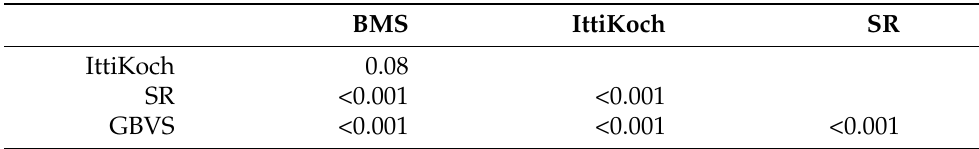
Table 2. p -Values obtained with a Nemenyi pairwise test for entropy.